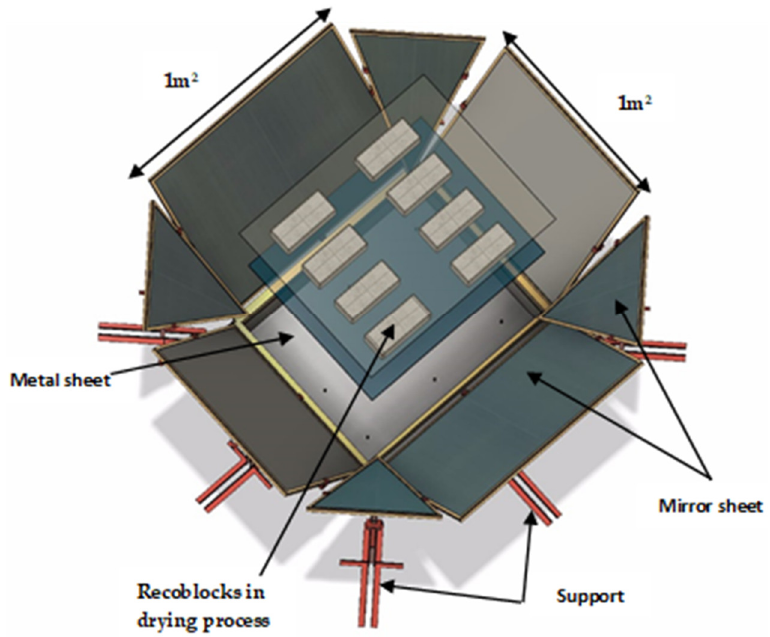
Figure 3. Solar dryer for Recoblocks.